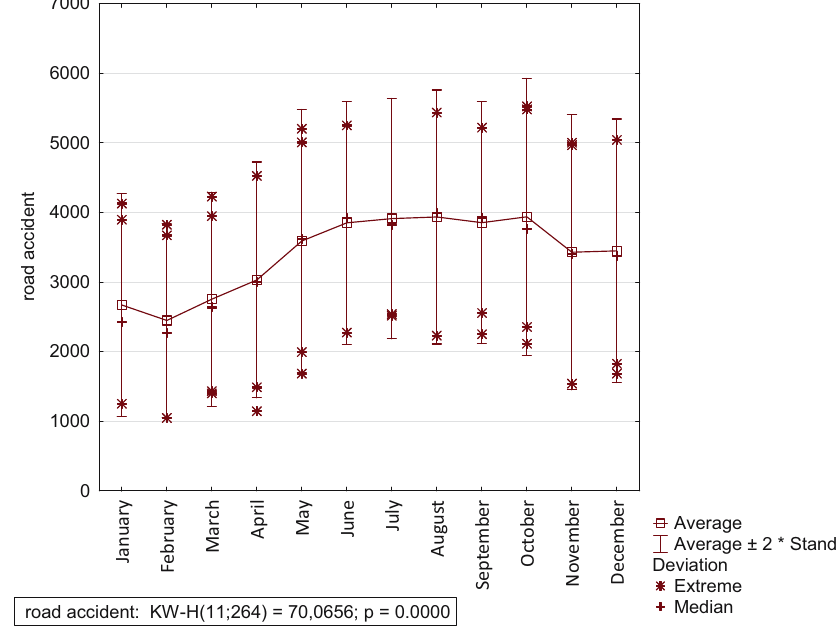
Figure 2: Comparison of the mean number of road accidents in Poland by month over the years 2000 –